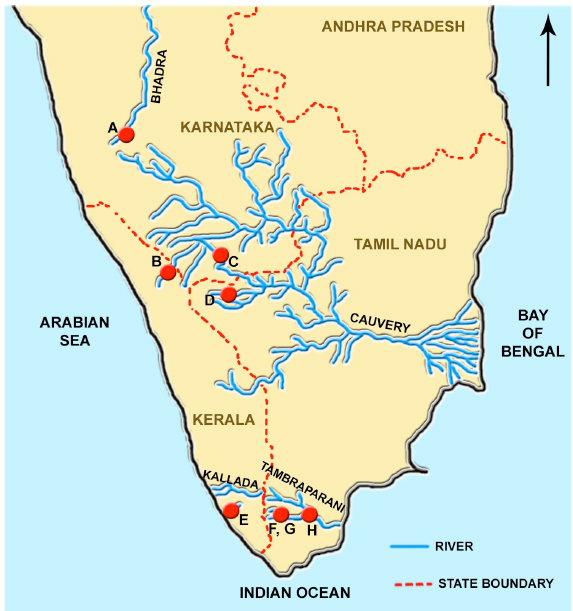
Figure 1. Descriptive map of southern peninsular India, showing the various locations from which P. arulius group of fishes were examined in this present study: A - KIOCL plant, Bhadra River; B - Khabini river; C - Bhavali River; D - Mavanahalla, Moyar River; E - Varkhala, Kallada River; F - Kodaimel Azhakian Anicut, Tambraparani River; G